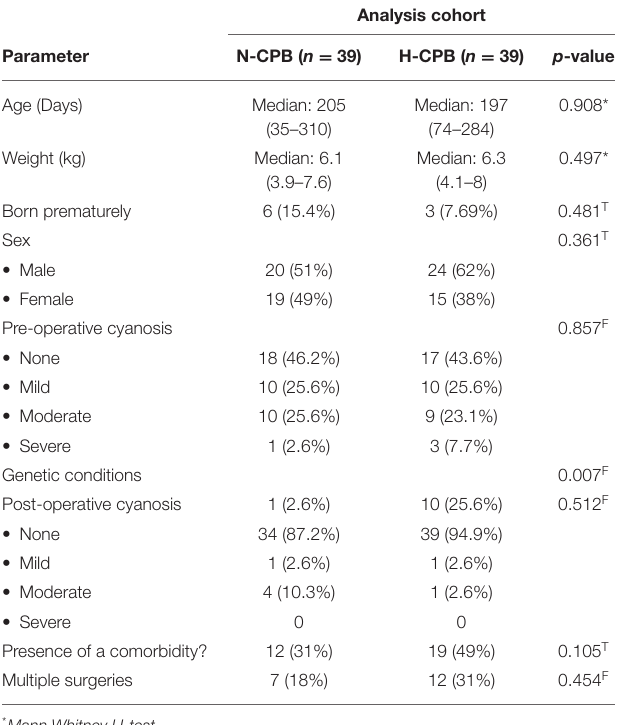
TABLE 2 | Patient demographics of those included in the analysis.